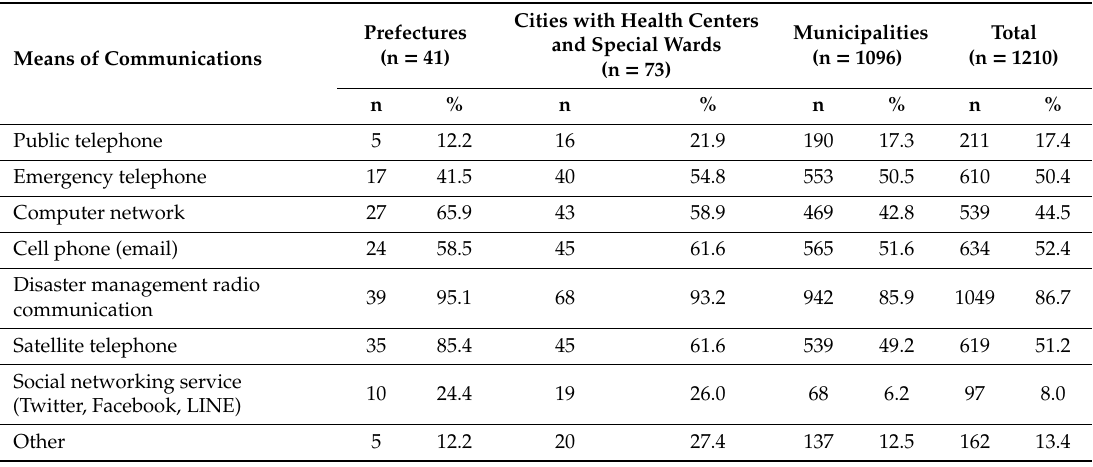
Table 1. Emergency communication tools listed in local disaster management plans, guidelines, or manuals. Data from 2013